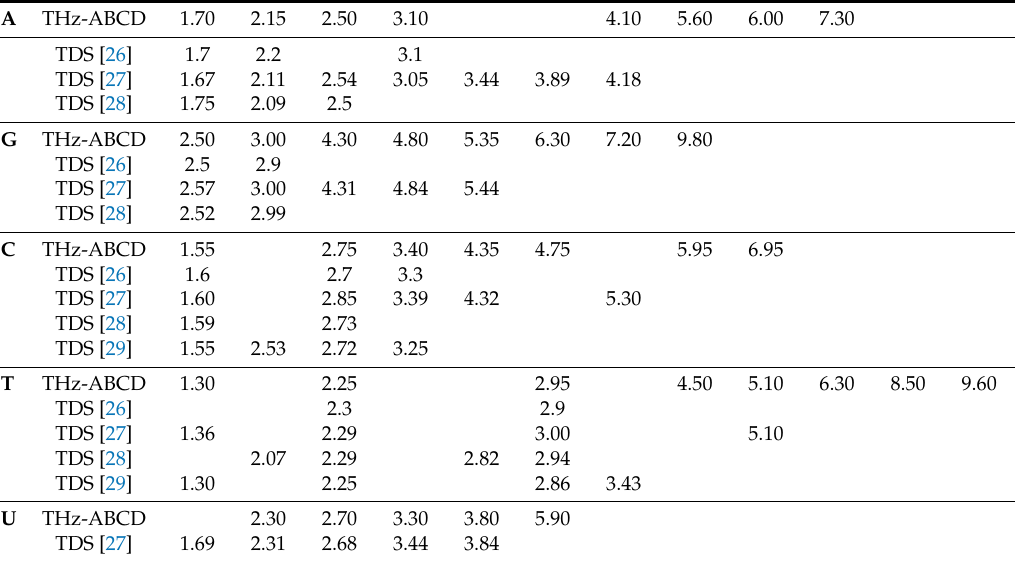
Table 2. The positions of absorption peaks of five nucleobases (unit: